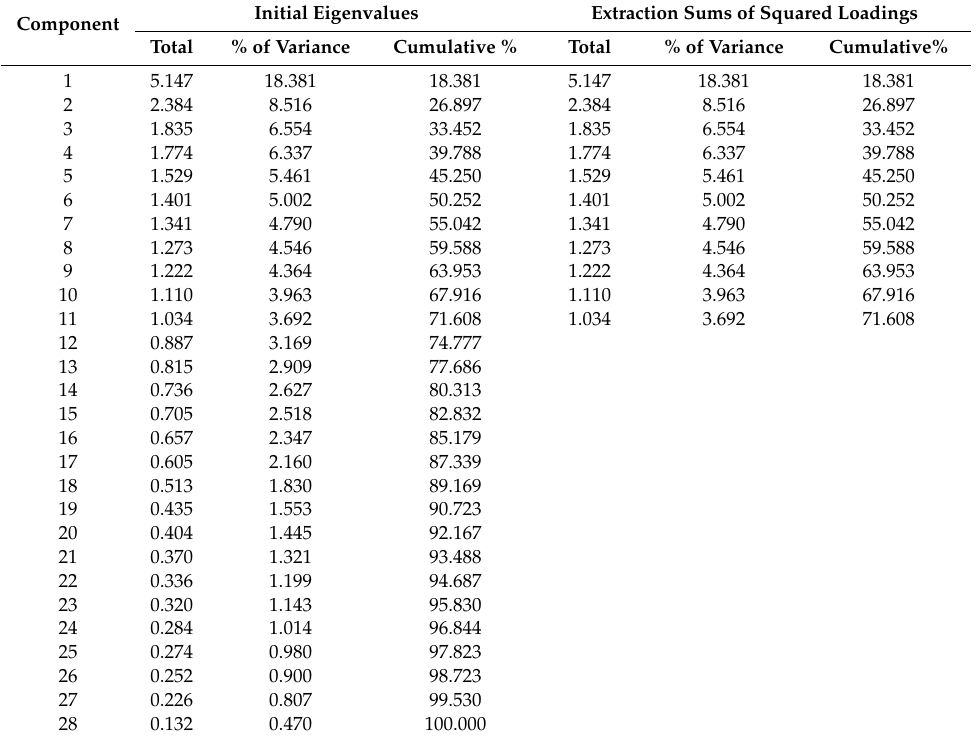
Table 2. Total explained variance.